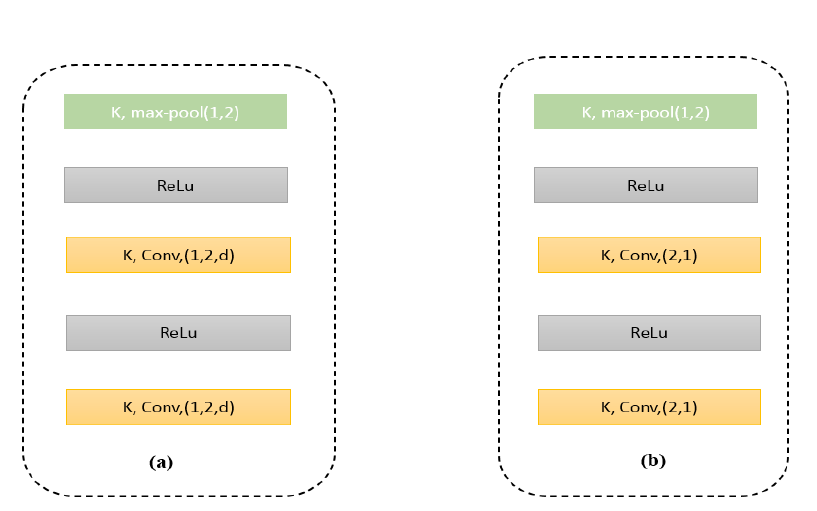
Fig. 5. Convolutional blocks. k is the number of filters. (a) HCB and (b)